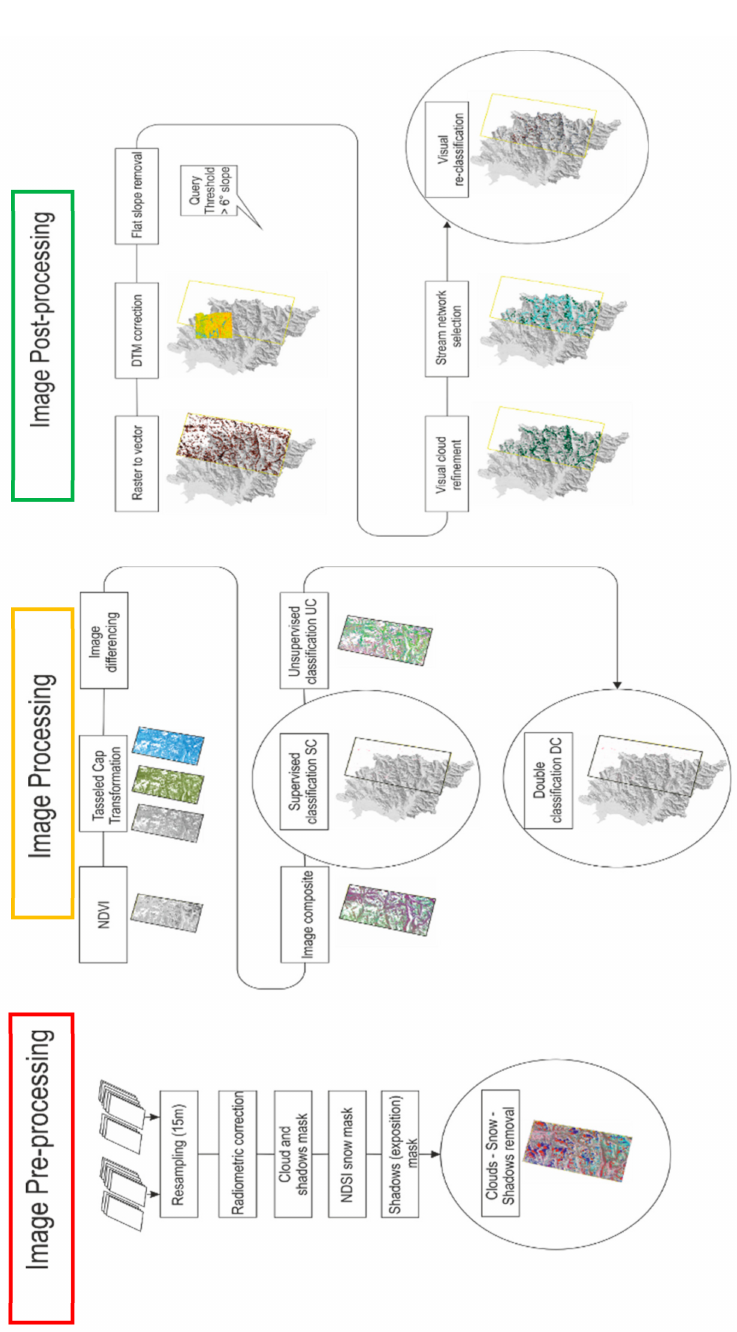
Figure 7. Methodology workflow for the proposed approach subdivided in (1) Image pre-processing; (2) Image processing; and (3) Image post-processing. (DTM hill shading